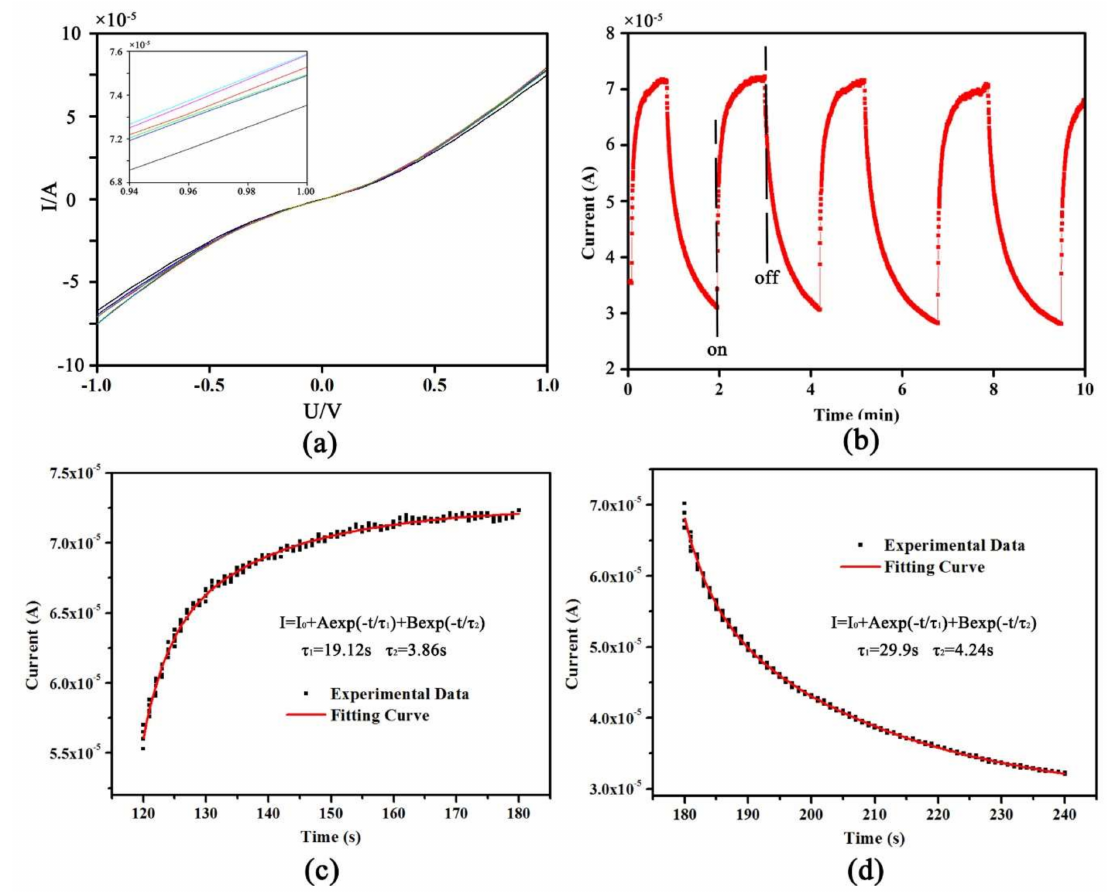
Figure 5. Characteristics testing results of ZnO nanowire device: ( a ) I–V characteristics; ( b ) ultraviolet characteristics at the bias voltage of 0.5 V; ( c ) rising process with the light; and ( d ) the decaying process of the current without the light (the solid curves represent fitting curve based on Equation